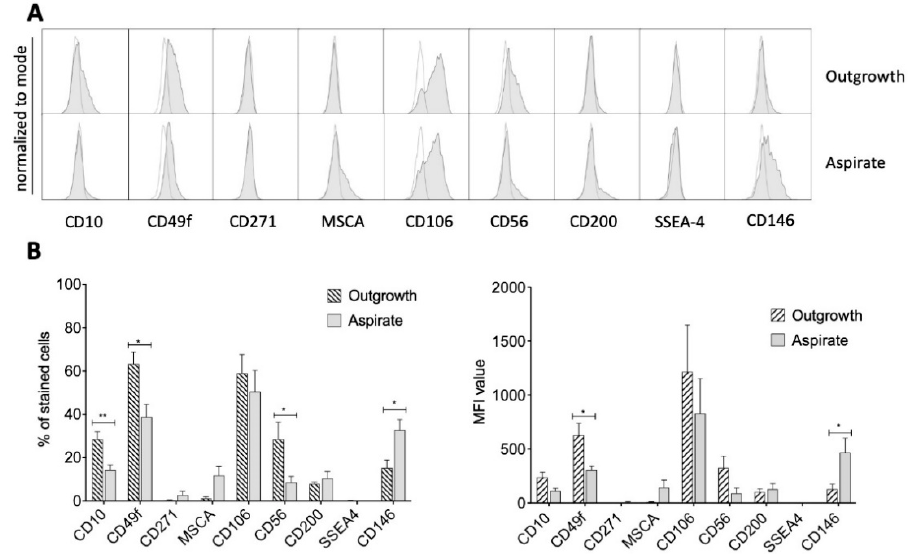
Figure 3. Expression of controversially discussed MSC markers. ( A ) Representative histograms (gray) indicated a distinct signal for CD49f and CD106. A weak signal was detected for CD10, MSCA, CD56, CD200 and both groups (aspirate and outgrowth) showed a lack of CD271 and SSEA4. White histograms represent controls. ( B ) Percentage of stained cells and their corresponding MFI confirmed the histograms. Furthermore, a statistically significant difference for the percentage of stained cells was detected for CD10, CD49f, CD56 and CD146, which was confirmed by significantly different MFI values for CD49f and CD146. * p < 0.05, ** p < 0.01.